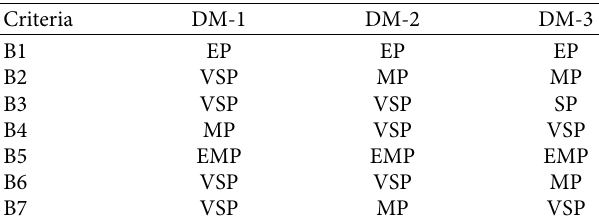
Table 5: In the case of the worst criterion, decision-makers’ lin- guistic preferences for all other criteria (others-to-worst vector).